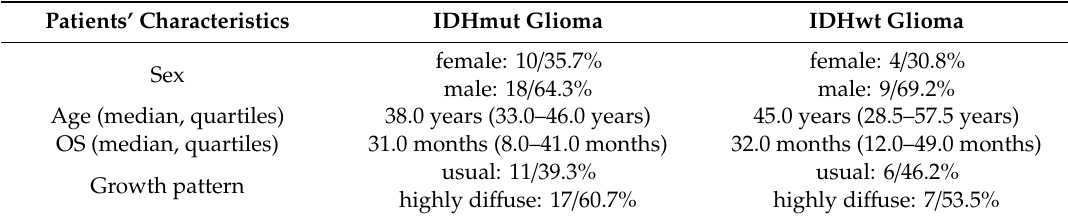
Table 1. Clinical parameters of IDHmut ( n = 28) and IDHwt glioma ( n = 13) patients.